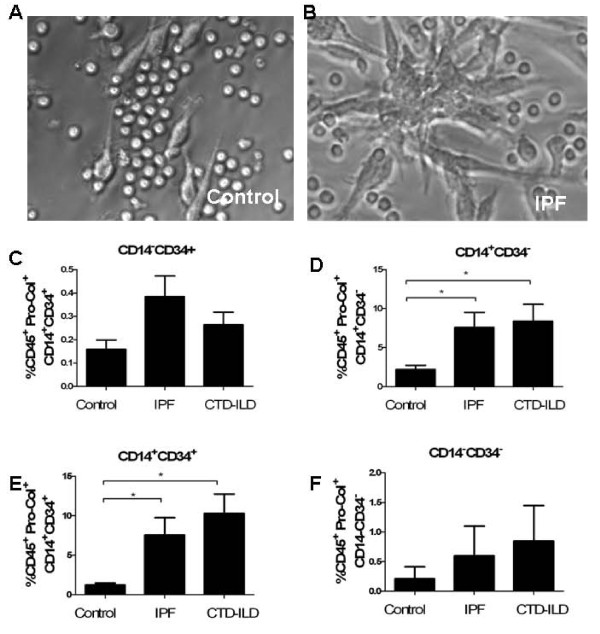
Cultured CD45 + Pro-collagen (Col)-Iα+ cells obtained from patients with pulmonary fibrosis demonstrate significant heterogeneity. (a,b) Spindle-shaped cells in cultured monocytes obtained from (a) control samples and (b) idiopathic pulmonary fibrosis (IPF) samples. The increase in number of spindle-shaped cells is seen in suggests an increase in fibrocytes. Similar results were seen in connective tissue disease interstitial lung disease (CTD-ILD) (data not shown). (c-f) Immunophenotyping of the cultured cells shown in (a) and (b). (c) In contrast to CD45+Pro-Col-Iα1+CD34+CD14- cells, which are quite rare and do not differ in frequency between normal (n = 8), (c), IPF (n = 7), and CTD-ILD (n = 11), CD45+Pro-Col-Iα1+CD34-CD14+ cells (d), as well as CD45+Pro-Col-Iα1+CD34+CD14+ cells (e) are increased in IPF and CTD-ILD patients. CD45+Pro-Col-Iα1+CD34-CD14- cells did not differ between groups (f). Among the patients with CTD-ILD, subgroup analysis did not detect a difference between systemic sclerosis (SSc)-ILD and amyopathic antisynthetase syndrome (AMAS) patients (data not shown). *P < 0.05 **P < 0.01 ***P < 0.001.